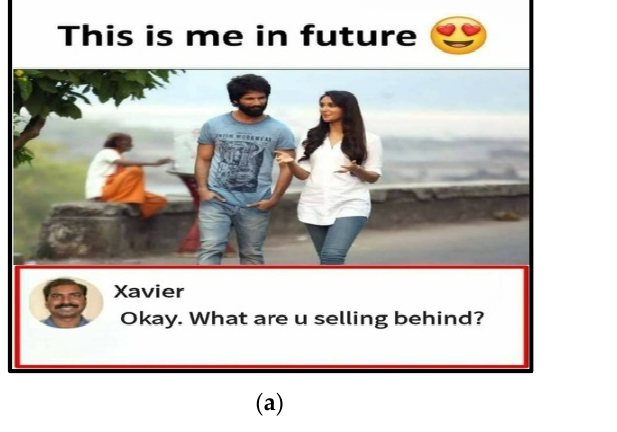
Figure 3. ( a ) Images with text [14]. ( b ) Images text and hashtags [14].